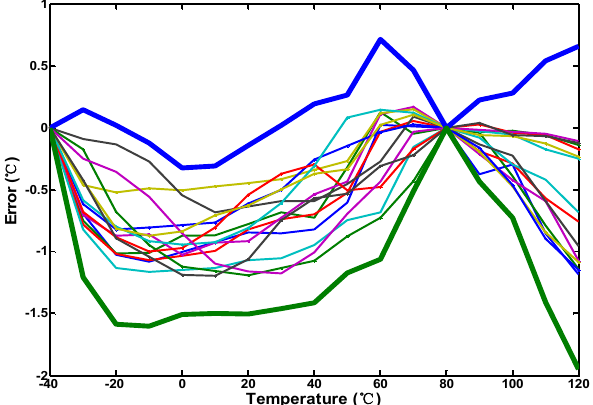
Figure 11. Measurement errors in the range of − 40–120 ° C for 14 test chips; bold lines indicate the ± 3 σ